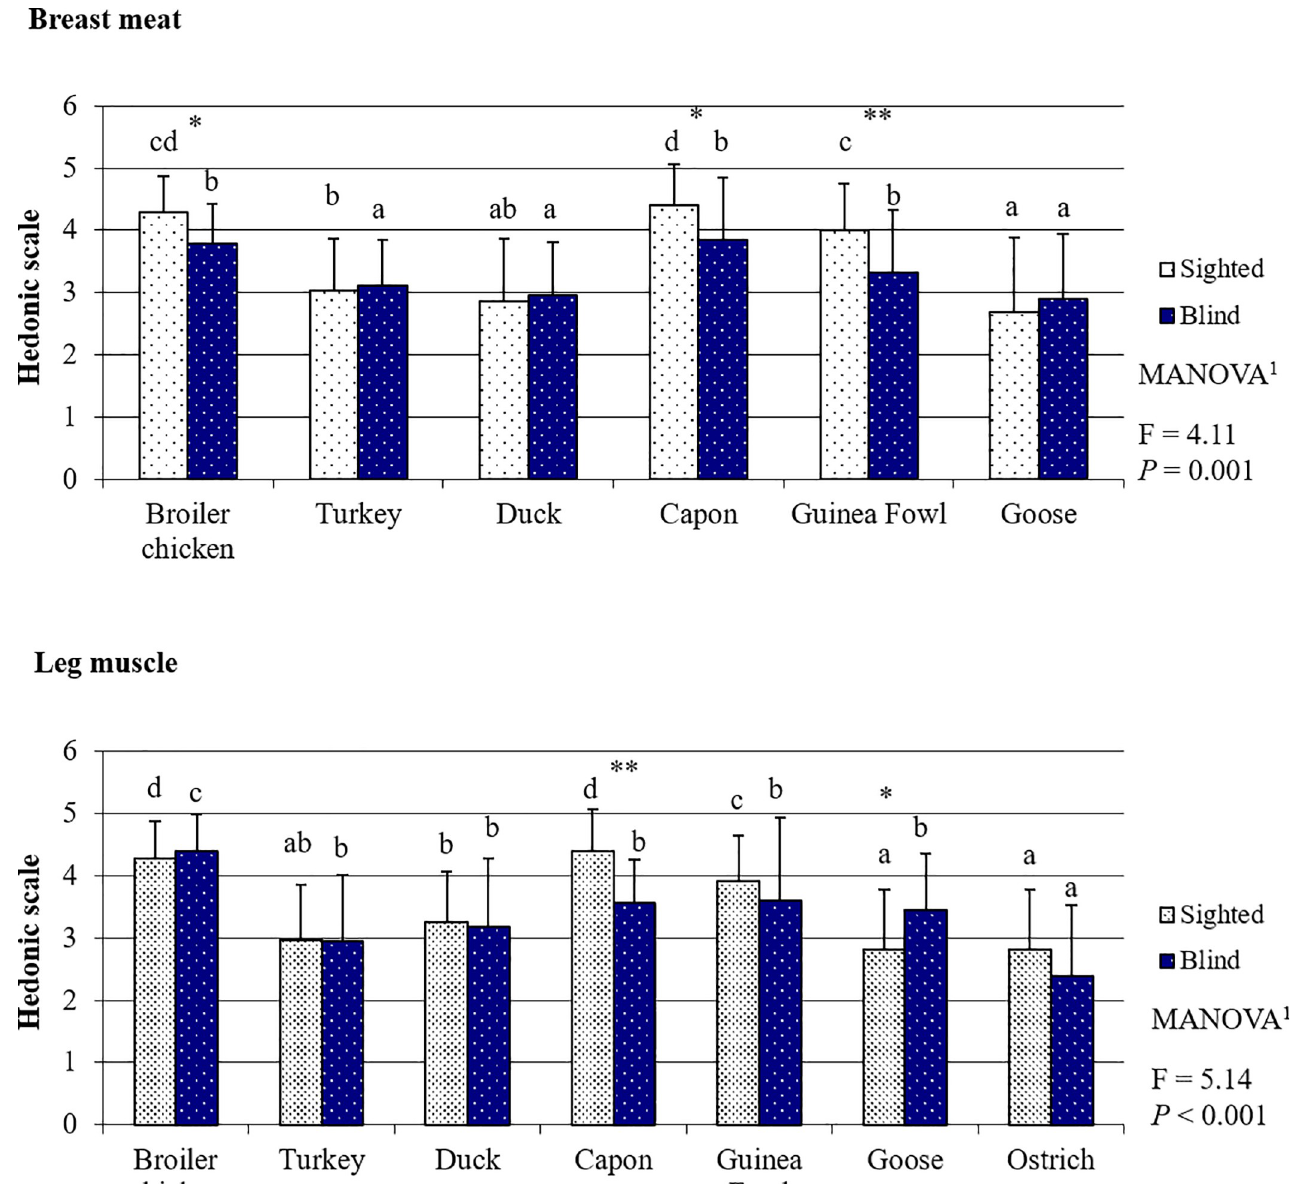
Fig 4. Poultry meat tenderness based on the evaluation by the sighted and blind panelists.